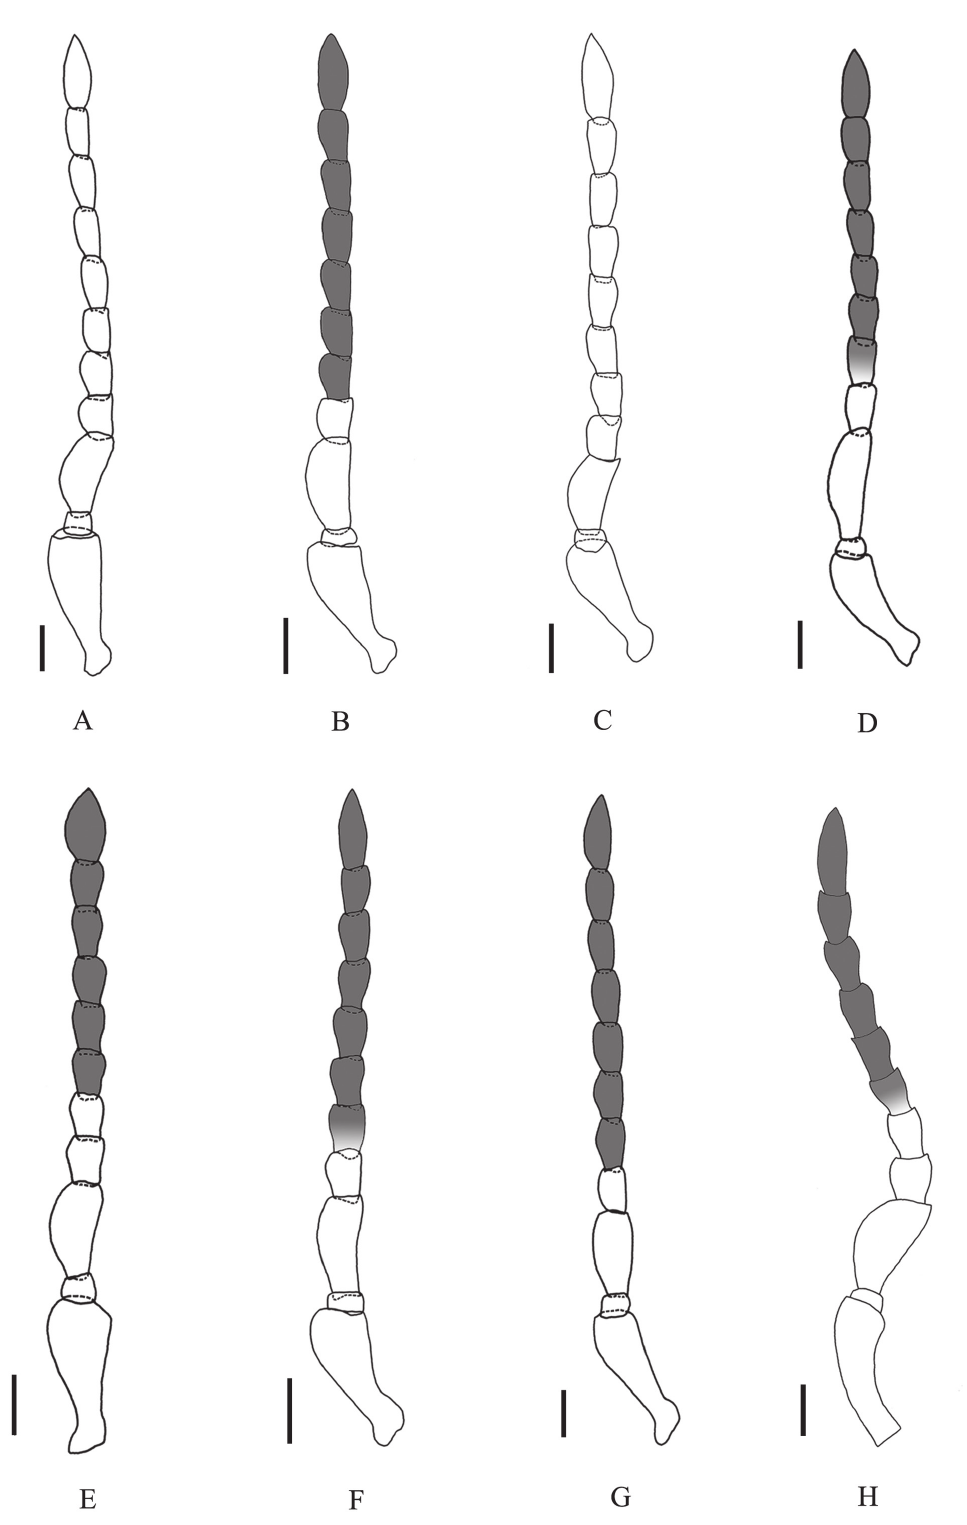
Fig. 5. Right antennae of Intybia spp., ♀. A . Intybia histrio (Kiesenwetter, 1874). B . I. tsushimensis (Satô & Ohbayashi, 1968). C . I. donan sp. nov. D . I. pelegrini pelegrini (Pic, 1910). E . I. niponica (Lewis, 1895). F . I. takaraensis (Nakane, 1955). G . I. kishiii (Nakane, 1955). H . I. kawasakii (Nakane, 1956). Scale bars = 0.2